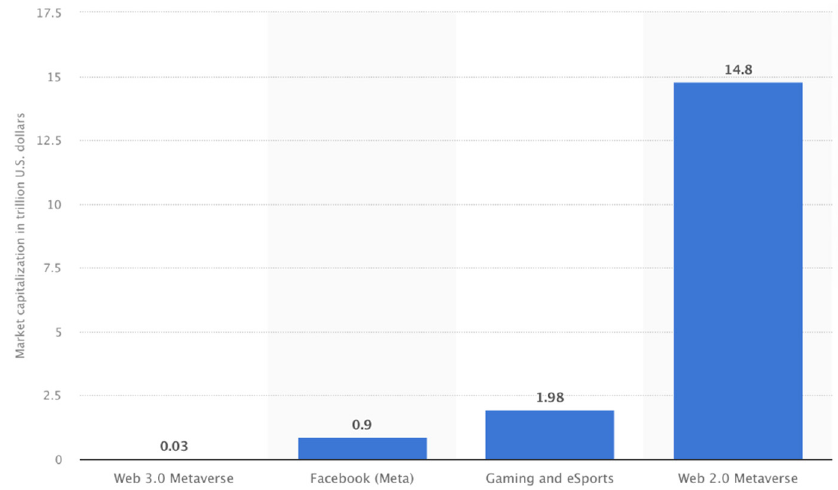
Figure 1. Market capitalization of the Metaverse, Meta, and gaming worldwide as of Oc- tober 2021